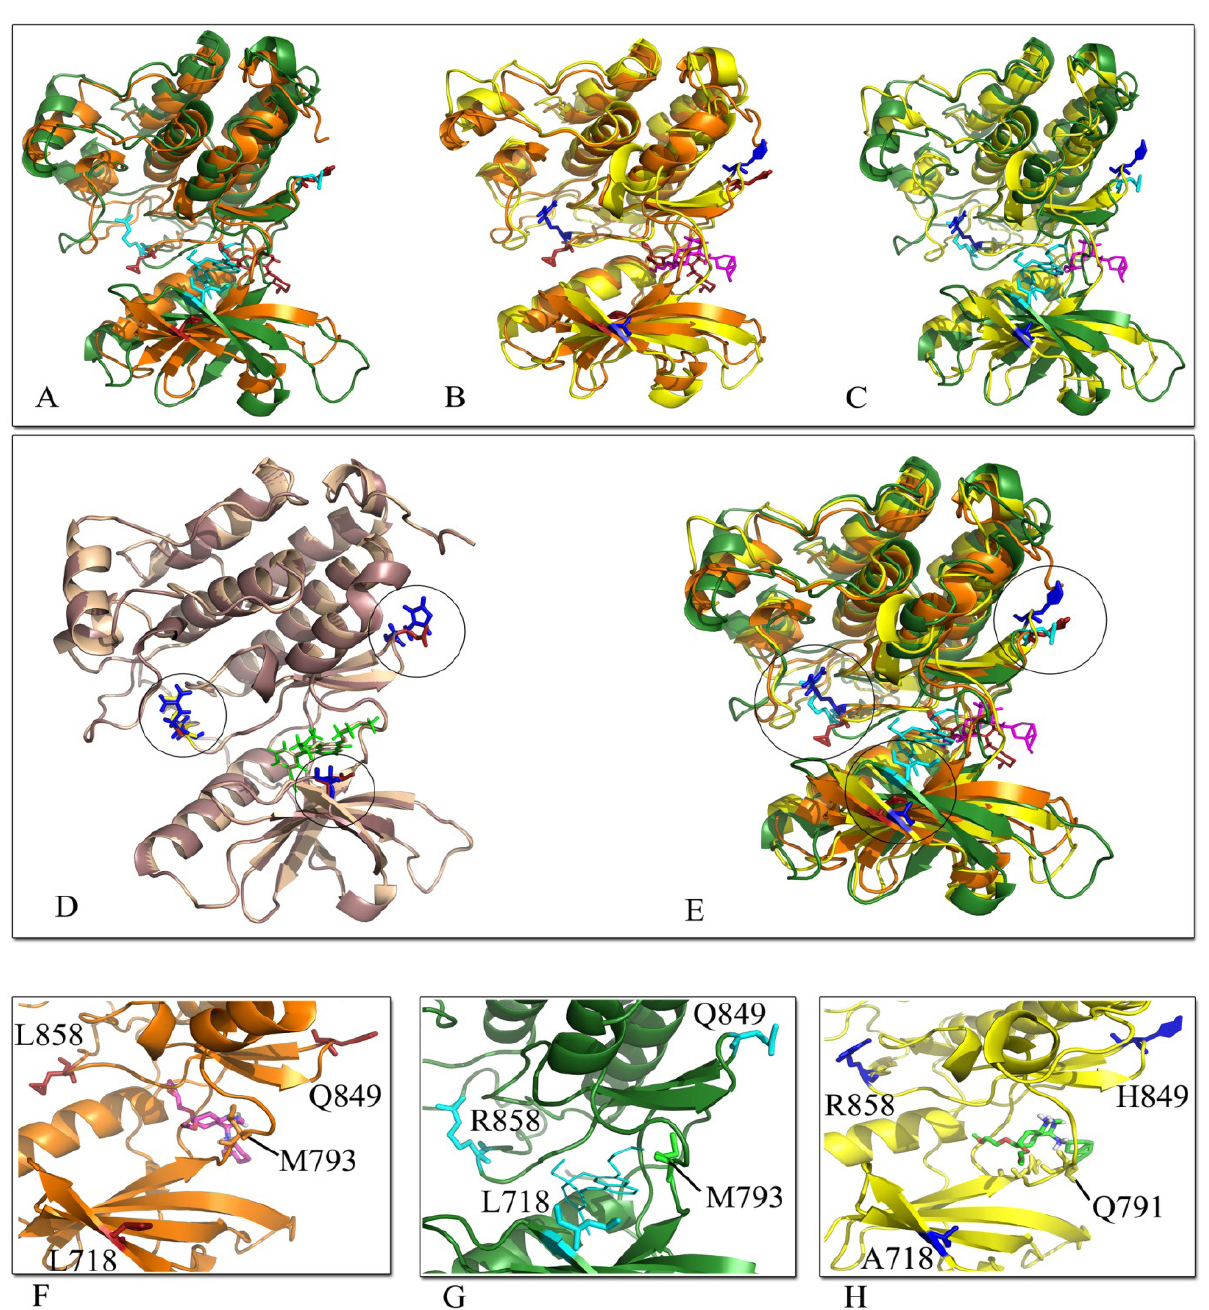
Figure 4: The binding pattern of wild-type, and EGFR variants to erlotinib before and after simulation. (A) Superimposition of wild-type and EGFR-L858R/erlotinib complexes (colored in orange, and green, respectively) , (B) Superimposition of wild-type and EGFR-AHR/erlotinib complexes (colored in orange, and yellow, respectively) , and (C) Superimposition of EGFR-L858R and EGFR-AHR/erlotinib complexes (colored in green, and yellow, respectively). (D) Superimposition of wild-type, EGFR-L858R, and EGFR-AHR/erlotinib complexes before MD (colored in slat blue, light and dark pink, respectively). Stick formats of residues 718, 849 and 858 of wild-type, EGFR-L858R, and EGFR-AHR are colored in red, yellow and blue, respectively. (E) Superimposition of wild-type, EGFR-L858R, and EGFR-AHR/erlotinib complexes after MD (colored in orange, green and yellow, respectively). Before MD simulation, L858R had not caused a detectable difference in protein compared to wild-type (the slat blue color of wild type is not distinct from the light pink color of the mutant). Stick formats of residues 718, 849 and 858 of wild-type, EGFR-L858R, and EGFR-AHR are colored in red, cyan and blue, respectively. ( F ) The binding pattern of wild-type EGFR to erlotinib (M793). ( G ) The binding pattern of EGFR-L858R to erlotinib (M793). ( H ) Binding pattern of EGFR-AHR to erlotinib (Q791). Erlotinib is colored in pink, cyan and green in complex with wild-type, EGFR-L858R, and EGFR-AHR,